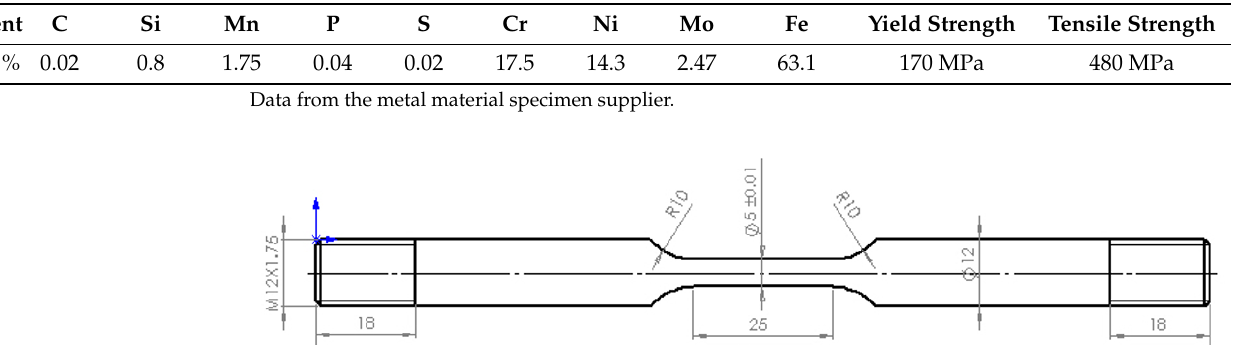
Table 2. Chemical composition, yield strength, and tensile strength of 316L stainless steel.